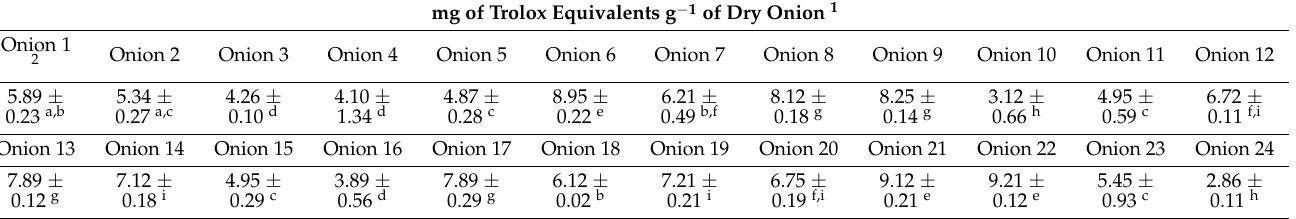
Table 4. Antioxidant activity ( n = 3) of the different onion varieties extracts obtained by the multi- response extraction method optimized in this study. Different letters mean statistically significant differences according to Tukey’s test at the 95% level of